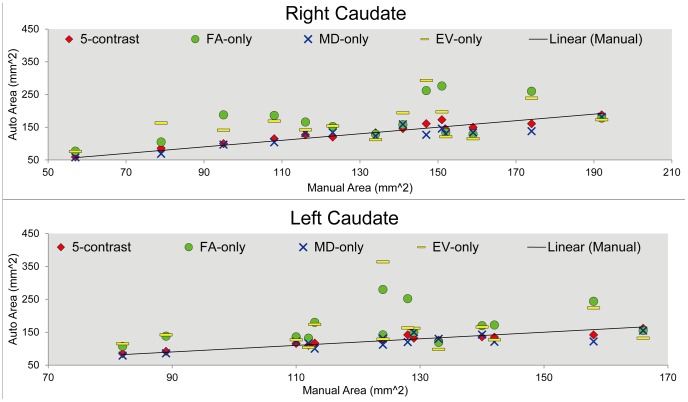
A correlation comparison of the automated caudate parcellation from using a single-contrast image and multi-contrast images.A plot of the correlation between the automated and the manual measurements of the size of the caudate in both hemispheres in square millimeters. Results from the four automated parcellation methods are compared: 5-contrast (red), FA-only (green), MD-only (blue), and EV-only (yellow).